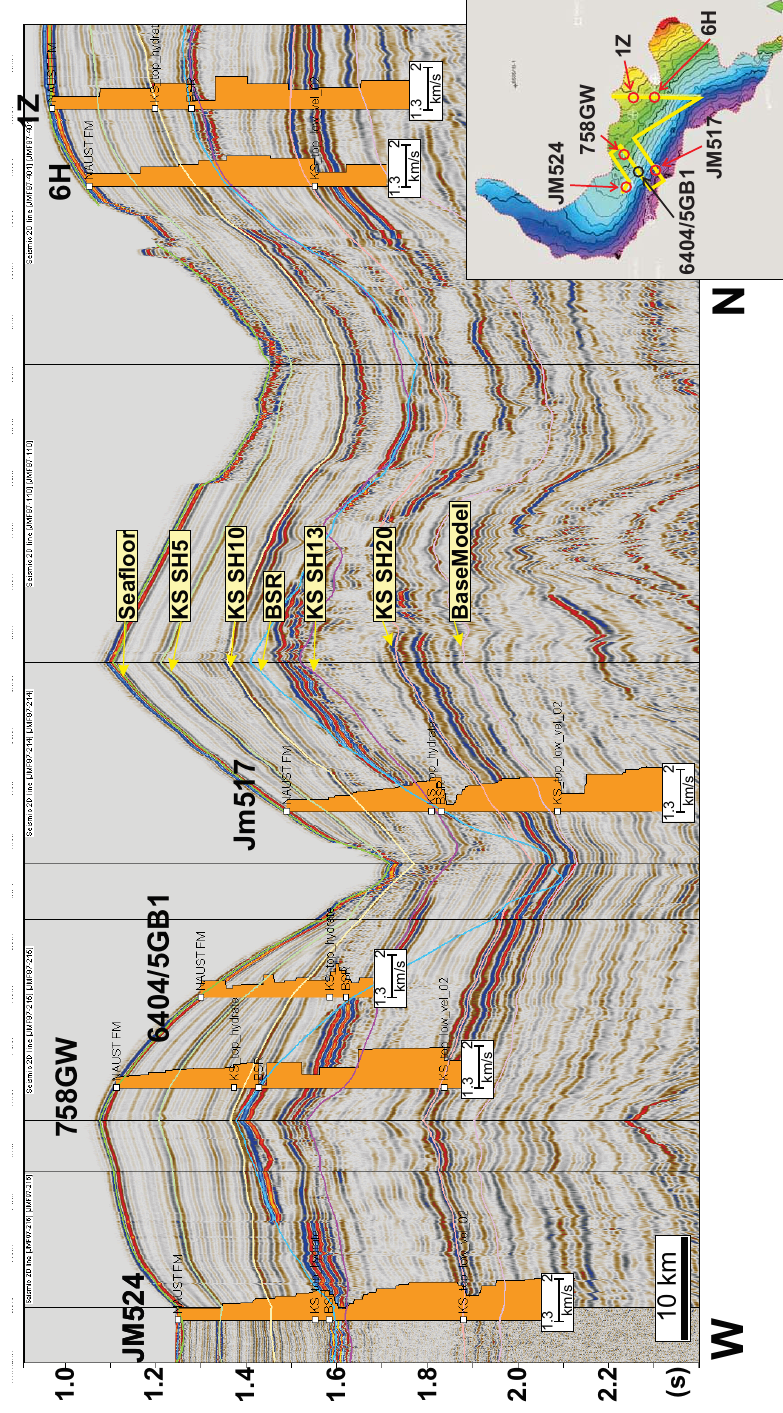
Figure 9. OBS-derived P-wave velocities as displayed on a composite seismic line. The illustration also provides an overview of the interpreted horizons. Note particularly the cross-cutting nature of the bottom simulating reflection (BSR). Furthermore, the P-wave velocity at OBS station 6H indicates no free gas layer at the expected BSR layer, leading to the reduction of the BSR-extent of Bünz et al. [62] in the volume calculation. Well tops are based on the OBS data. OBS data from Bünz et al. [56], Westbrook et al. [58] and Faverola et al.